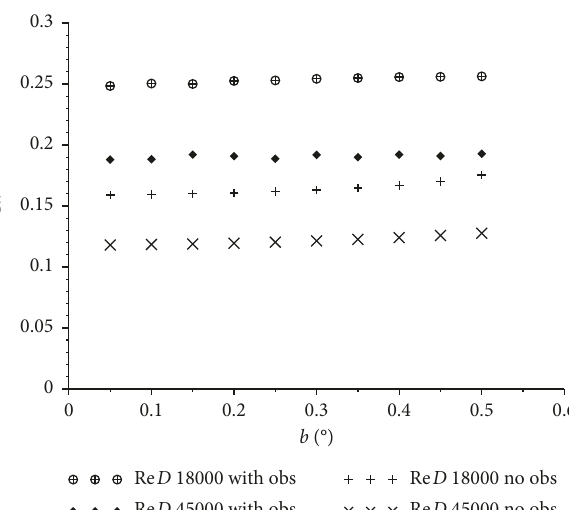
Figure 11: Approximation of Cn / Ct .